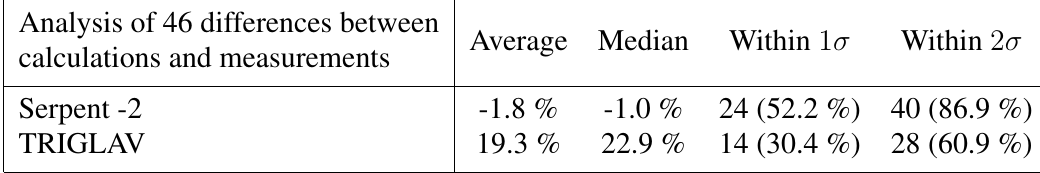
Table 1: Statistical analysis of differences between the measured and calculated linear burnup reactivity coefficient. Total number of coefficients is 46, which represent 46 different core configurations and 2000 measurements of excess reactivity in